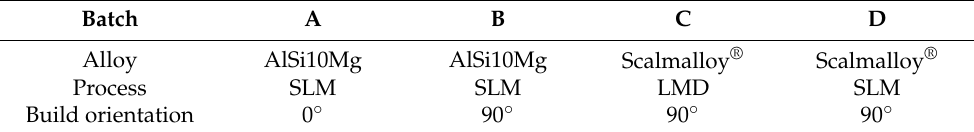
Table 1. Study design for comparison of mechanical properties of AlSi10Mg and Scalmalloy ® .